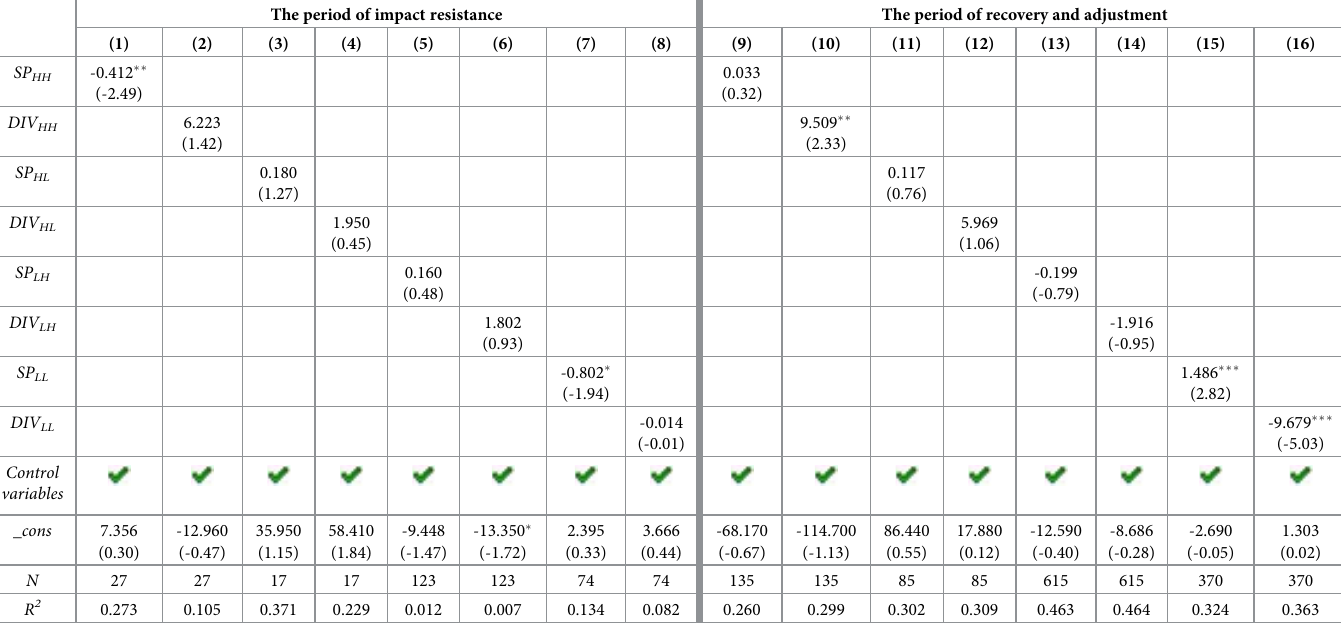
Table 6. The effects of dual industry agglomeration on urban economic resilience. The period of impact